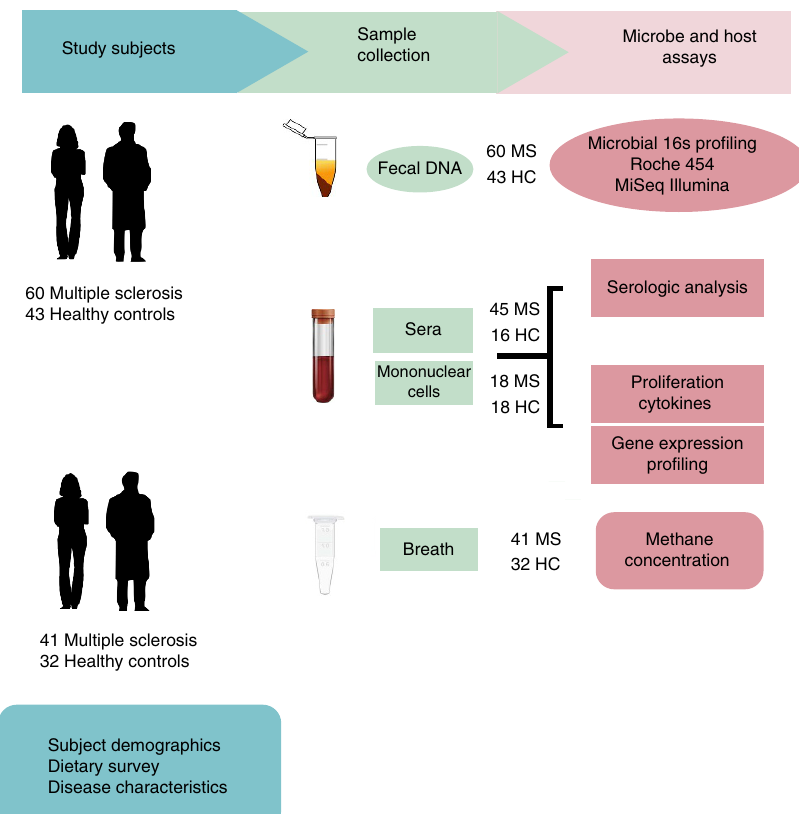
Figure 1 | Study design. Faecal samples were collected from MS patients ( n ¼ 60) and healthy subjects ( n ¼ 43). Microbial DNA was extracted from frozen faecal samples and 16s rDNA sequencing was performed using Roche 454 and Illumina platforms. Gene expression profiling was performed on circulating monocytes and T cells from MS patients ( n ¼ 18) and healthy subjects ( n ¼ 18) using a Nanostring platform. Peripheral blood mononuclear cells were collected from MS patients ( n ¼ 18) and healthy subjects ( n ¼ 18) to conduct proliferation and cytokine assays in response to specific microbial stimulation. Sera from MS patients ( n ¼ 45) and healthy subjects ( n ¼ 16) was collected for ELISA-based techniques to capture serologic activity directed against specific microbes. Breath samples from MS patients ( n ¼ 41) and healthy subjects ( n ¼ 32) were collected from a second subject cohort to determine breath methane